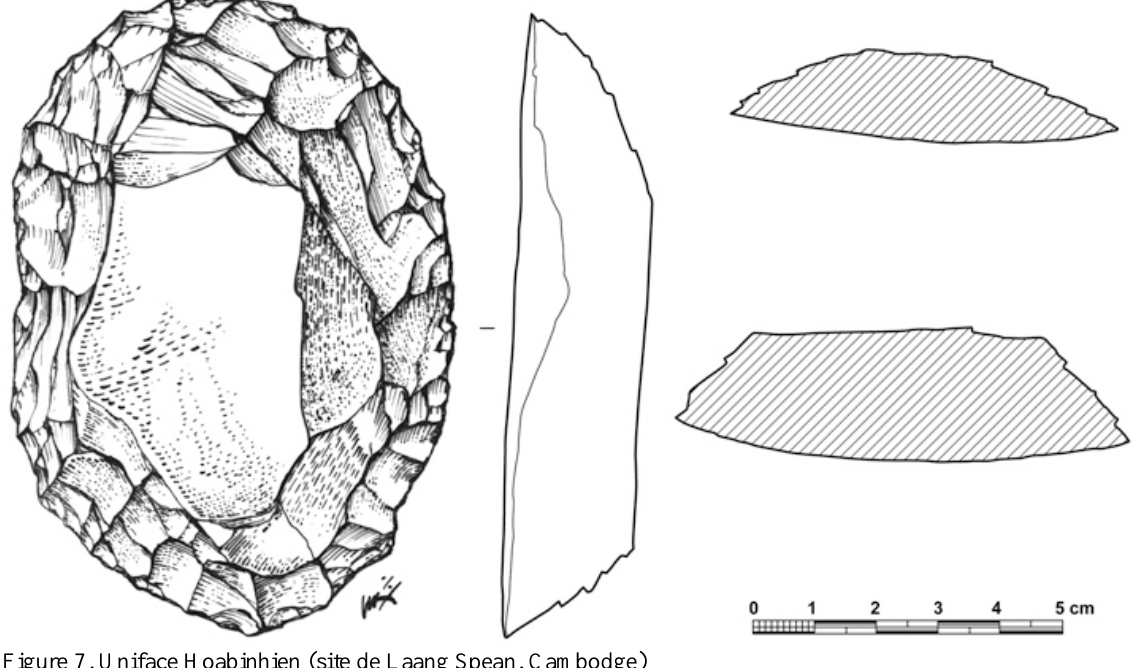
Figure 7. Uniface Hoabinhien (site de Laang Spean, Cambodge) Figure 7. Hoabinhian uniface (Laang Spean site,